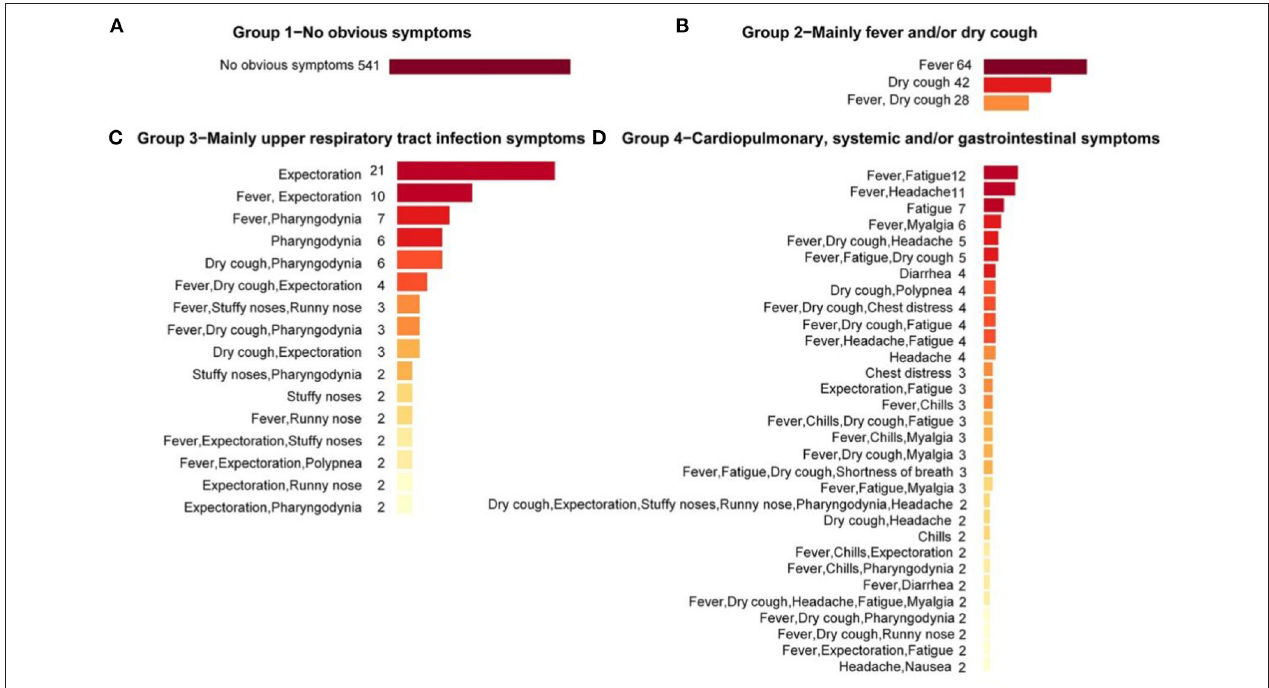
FIGURE 2 | Symptom combinations under different symptom groups. Symptom combinations with only one case in symptom Groups 3 and 4 were not included. (A) The Group 1 with no obvious symptoms; (B) The Group 2 with main symptoms were fever and/or dry cough; (C) The Group 3 with main symptoms were upper respiratory tract infection symptoms; (D) The Group 4 with main symptoms were cardiopulmonary, systemic and/or gastrointestinal